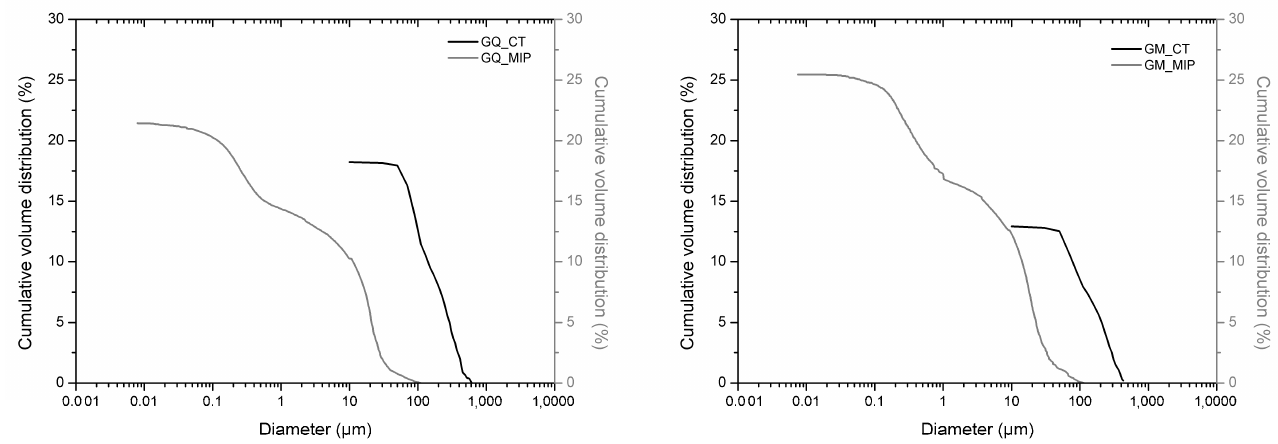
Figure 13. µCT (gray) and MIP (black) cumulative porosity combined graphs of samples GQ ( left ) and GM ( right ).